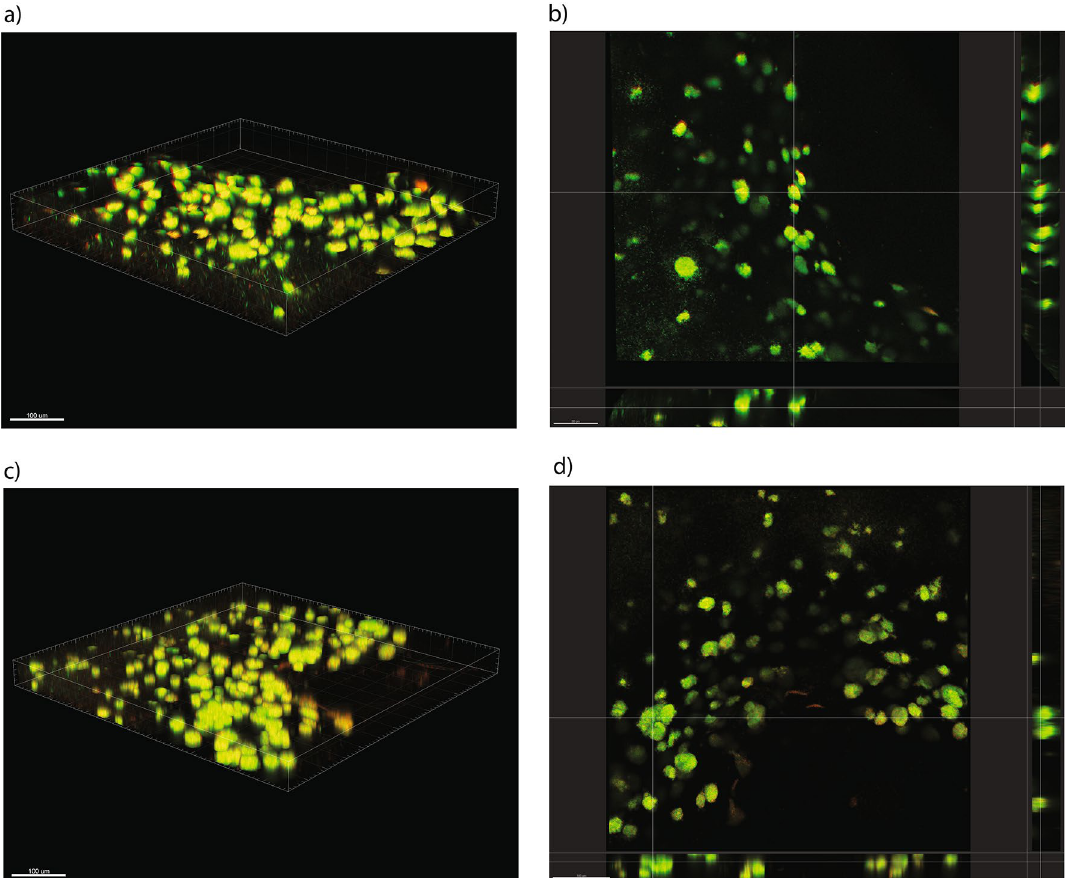
Figure 6. Confocal imaging analysis (3D and cross sectional) of biofilm structure of N. gonorrhoeae isolates ( a , b ) NG-083 and ( c , d ) NG-091treated with MIC concentration (0.125 mg/L) of